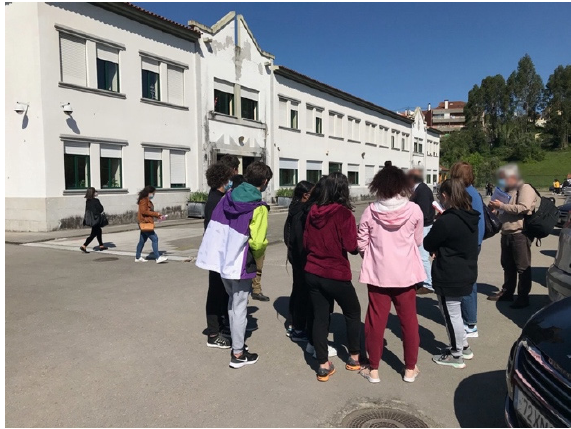
Figure 7 . Escola Básica Rainha Santa Isabel (EBRS) — walkthrough. Figure 7. Escola B á sica Rainha Santa Isabel